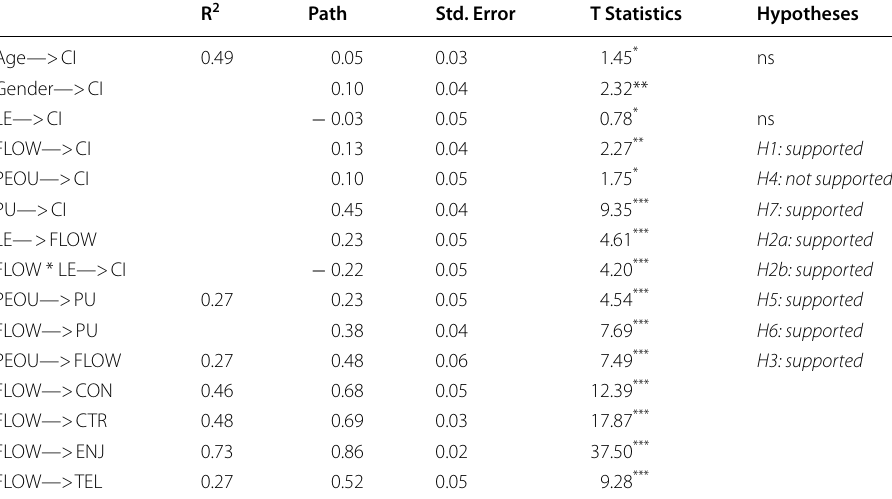
Path Coefficient * not significant; **significant at p < 0.05; ***significant at p < 0.001 =